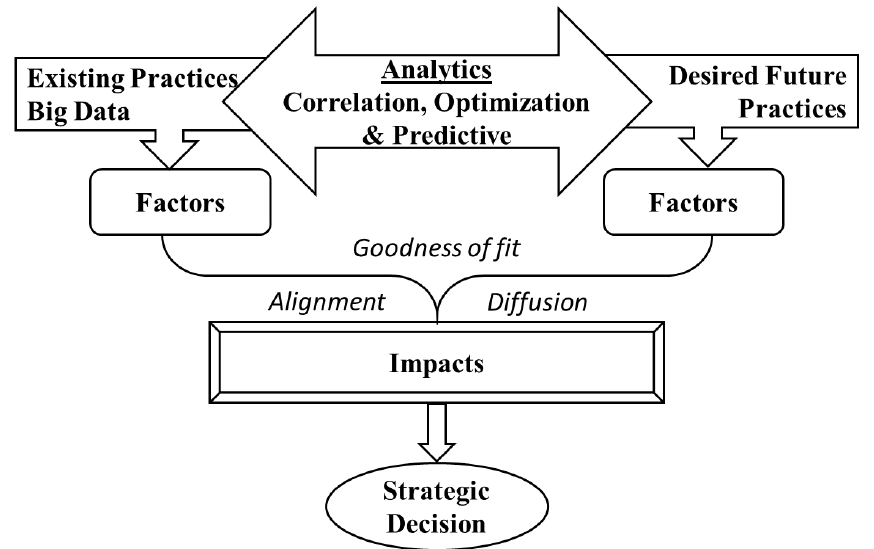
Fig. 12. Matrix of Change Applying Big Data